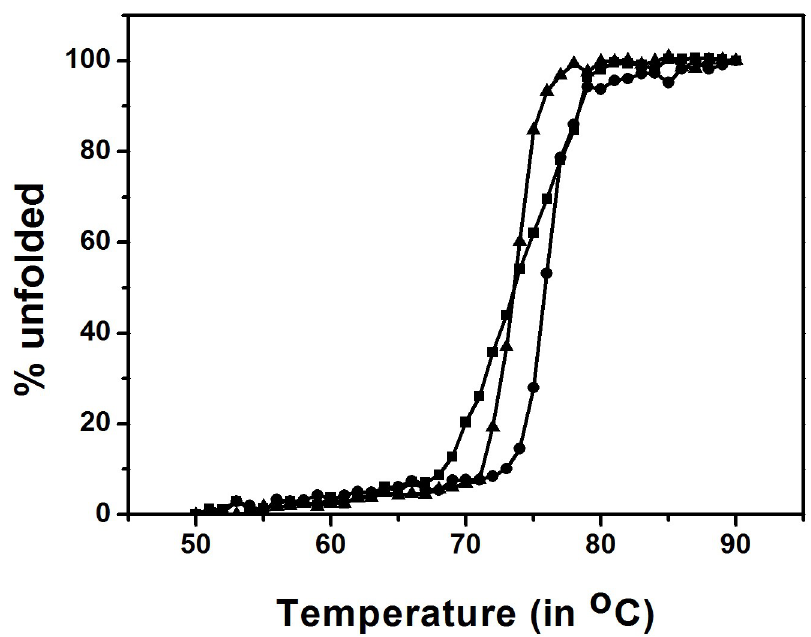
Fig 7. Thermal unfolding of GTL and its mutants. Fraction unfolded was calculated from the ellipticity at 222 nm. GTL is represented by circle, DM-GTL by triangle and CM-GTL by square.